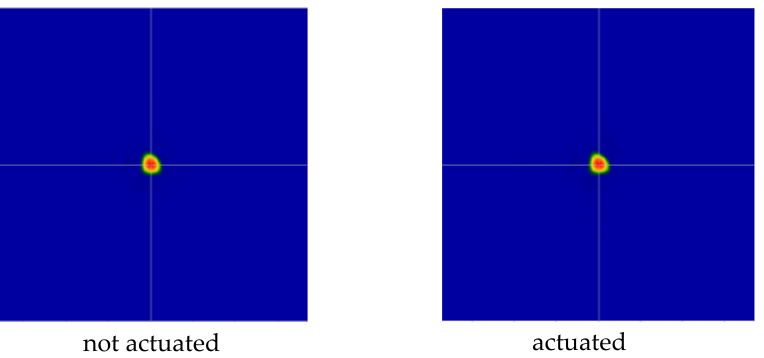
Figure 13. As an example, 2 “qualitative” FFDPs of sample 1, mirror b, computed through the interferometer software in arbitrary units, at the operational wavelength of 633 nm.